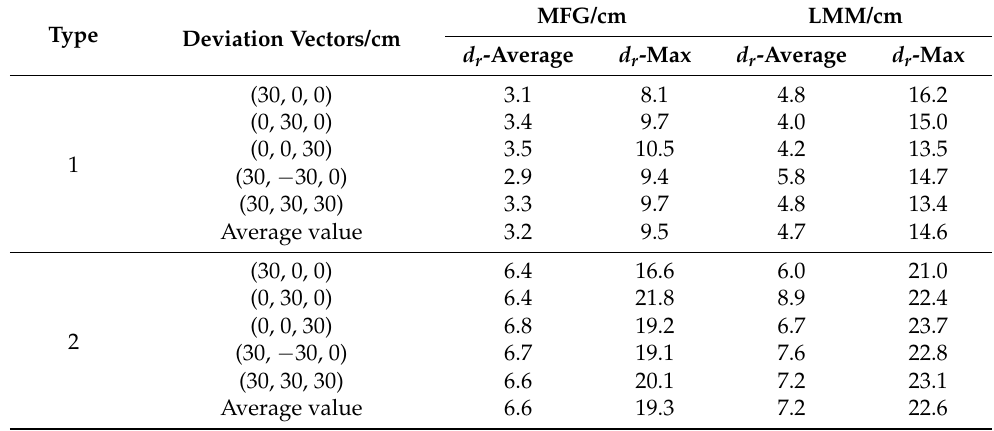
Table 3. Average absolute errors with different numbers.